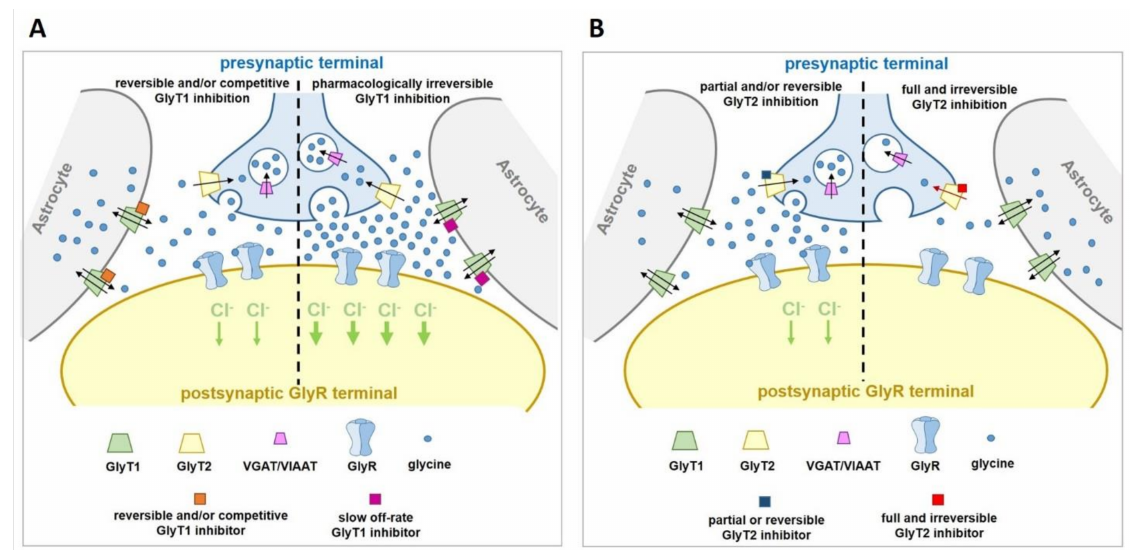
Figure 4. Potential functional consequences of GlyT inhibition. ( A ) Reversible GlyT1 inhibition with rapid dissociation (shown on the left) versus prolonged inhibition via slow dissociation (shown on the right) at an inhibitory glycinergic synapse. A slowly dissociating GlyT1 inhibitor (magenta square e.g., ALX5407) can potentially generate a sustained and excessive increase in synaptic glycine that can ultimately lead to robust and prolonged GlyR activity. This hyperglycinergic state is believed to underlie the severe motor impairment and respiratory depression observed for tight binding GlyT1 inhibitors. Reversible GlyT1 inhibitors (orange square, e.g., bitopertin), that slowed the clearance of synaptic glycine while also allowing for glycine reuptake, were found to exhibit significantly improved safety profiles. ( B ) Partial or reversible GlyT2 inhibition with rapid dissociation (shown on the left) versus full GlyT2 inhibition and slow dissociation (shown on the right) at an inhibitory glycinergic synapse. A slowly dissociating GlyT2 inhibitor (red square e.g., ORG25543) will initially generate an increase in synaptic glycine concentrations but will ultimately prevent glycine reloading of synaptic vesicles and reduce both glycine release and GlyR activity. A partial or reversible inhibitor that rapidly dissociates (blue square) will slow the clearance of synaptic glycine, increase GlyR activity, and also allow for glycine reuptake and reloading of